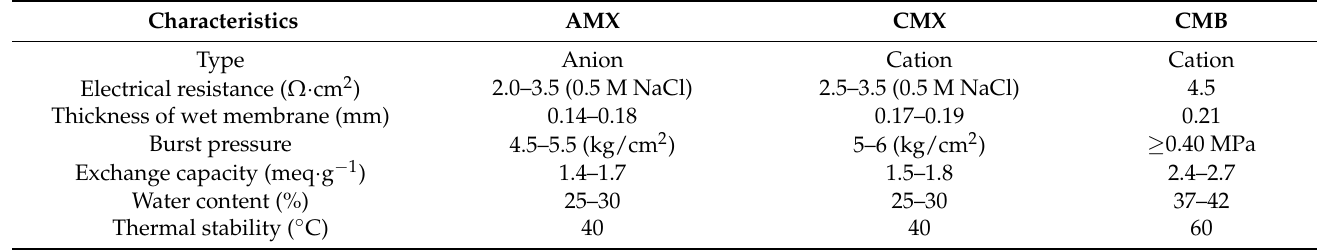
Table 1. Monopolar membranes’ technical specifications